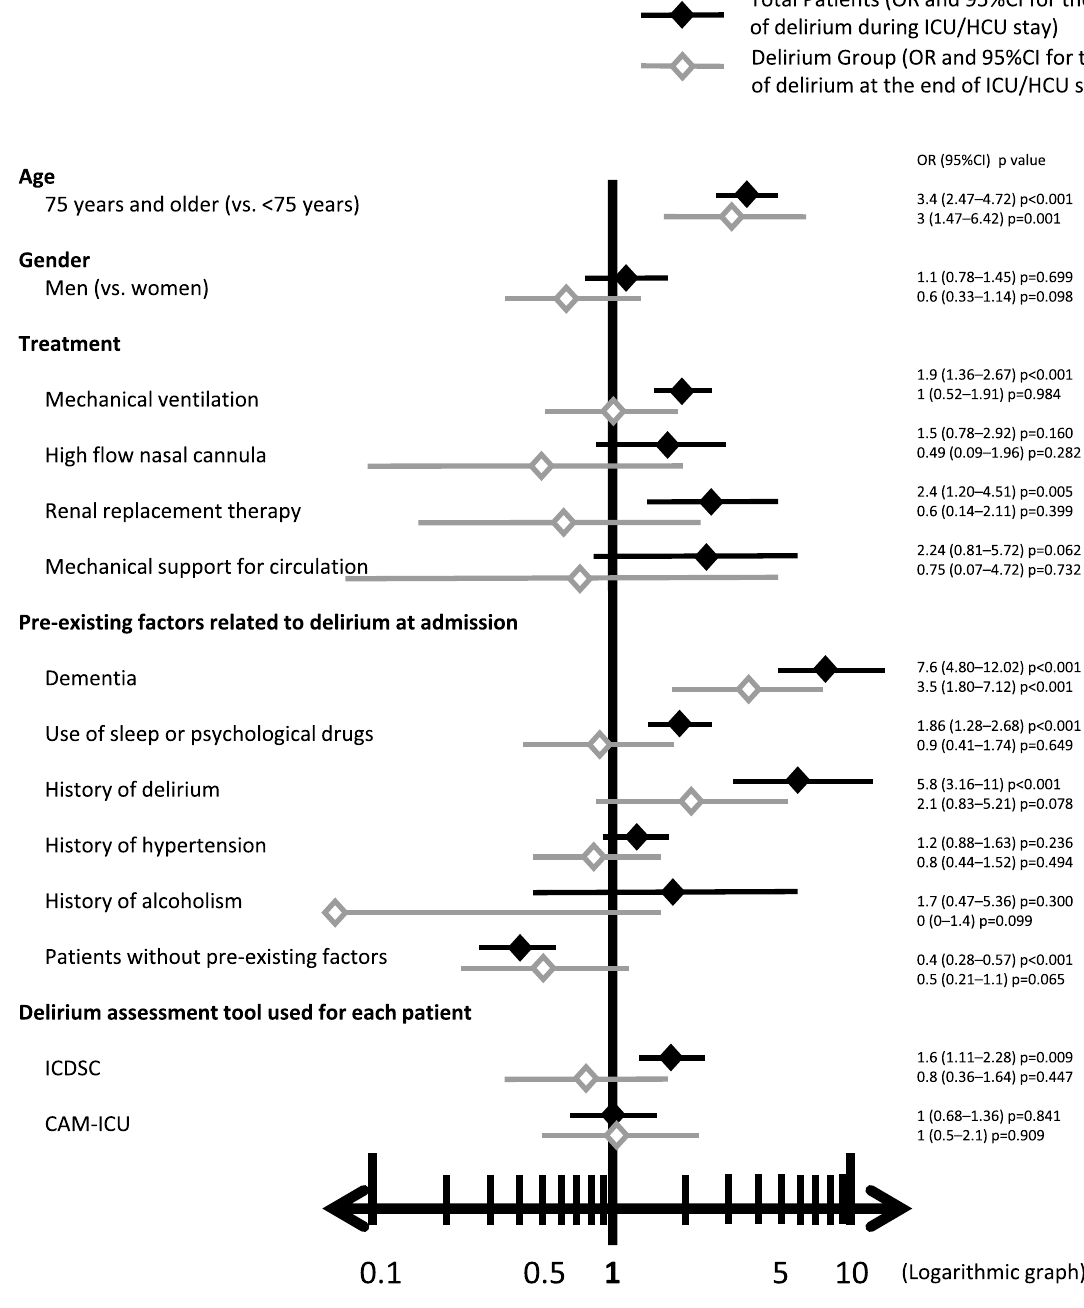
Figure 1. Odds ratio (OR) and 95% confidence interval (95%CI) for each potential factor related to delirium in total patients (development of delirium during ICU/HCU stay) and the delirium group (presence of delirium at the end of ICU/HCU stay). ICU intensive care unit, ICDSC Intensive Care Delirium Screening Checklist, CAM- ICU Confusion Assessment Method for the Intensive Care